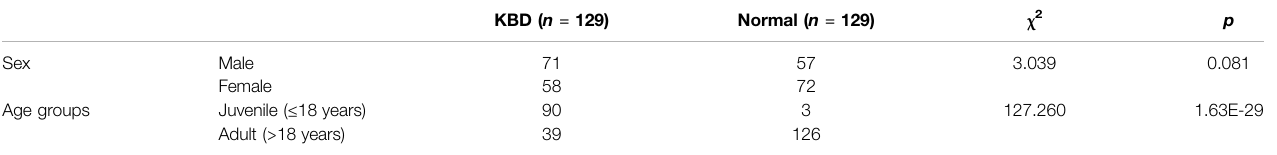
TABLE 1 | General information of subjects for SNP detection.